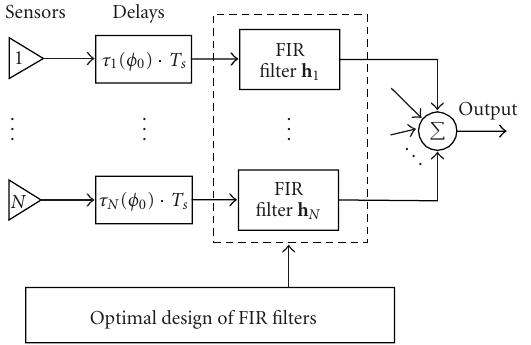
Figure 1: FIR broadband beamformer